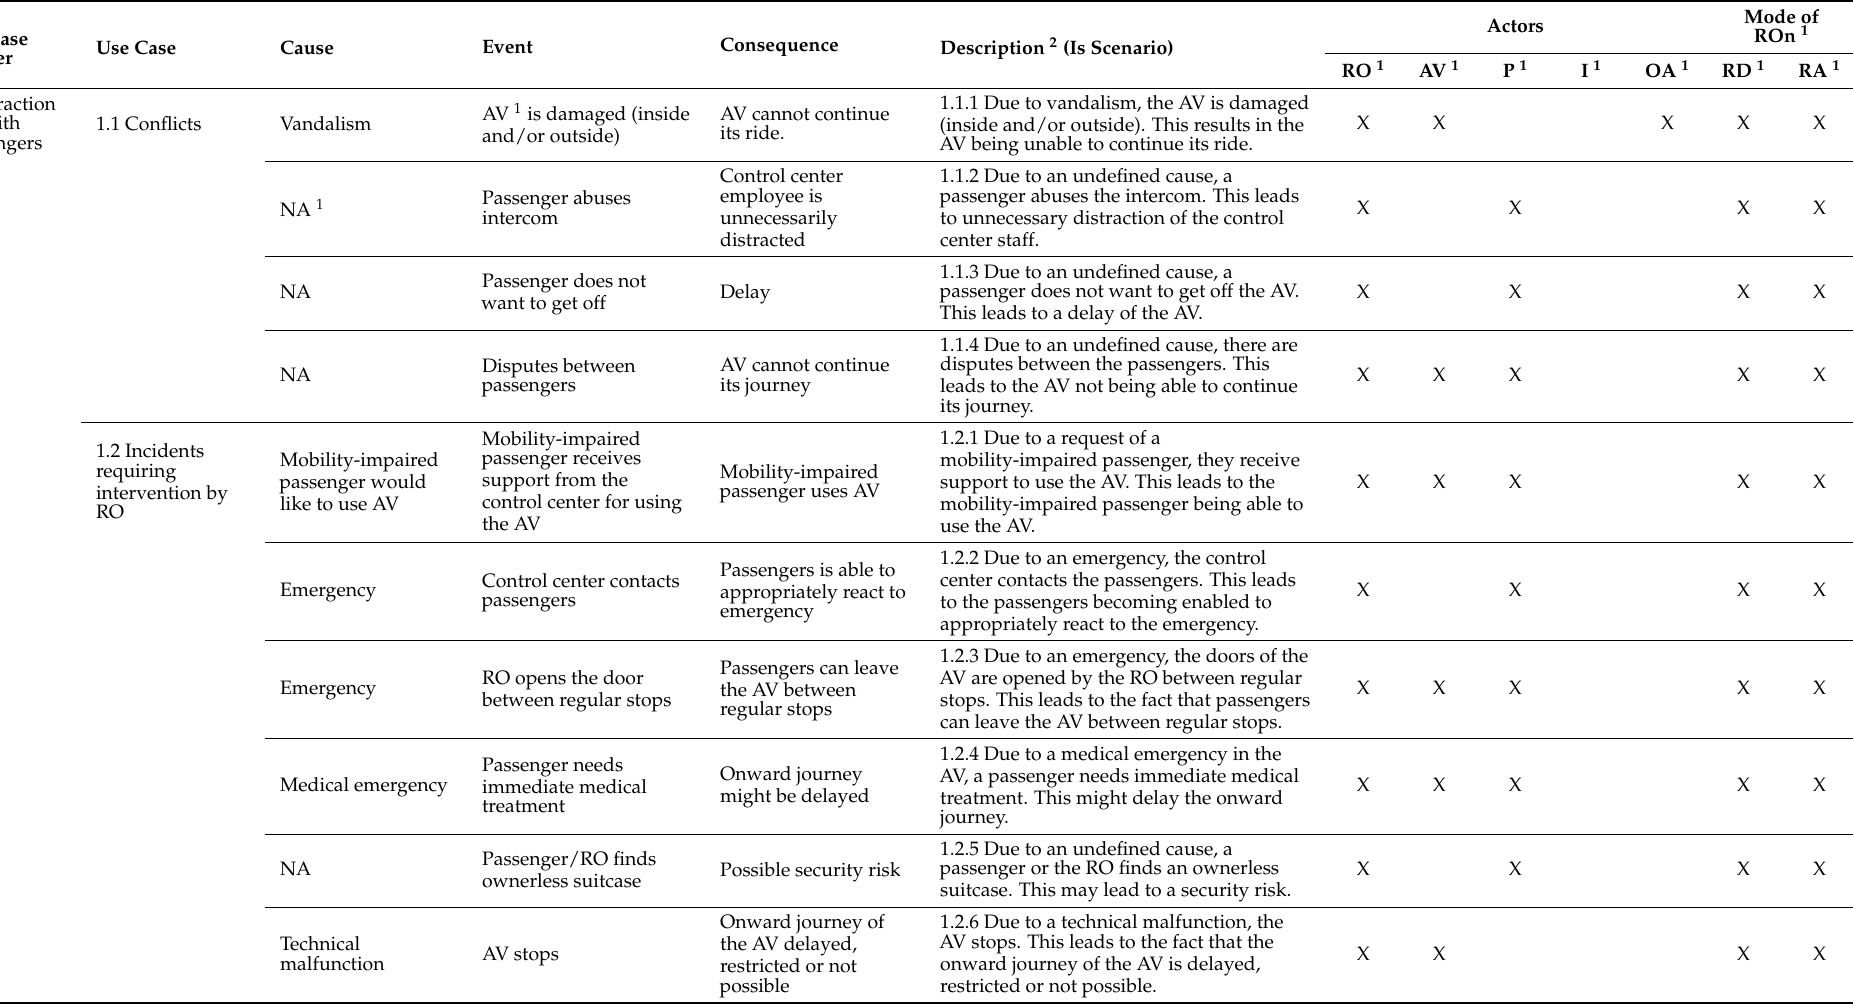
Table 1. Comprehensive list of scenarios in remote operation compiled. A classificatory number indicates the use case cluster (UCC), use case (UC) and Is Scenario (Sc) in the following way: < N UCC > . < N UC > . < N Sc >. × indicates that an option applies for a given